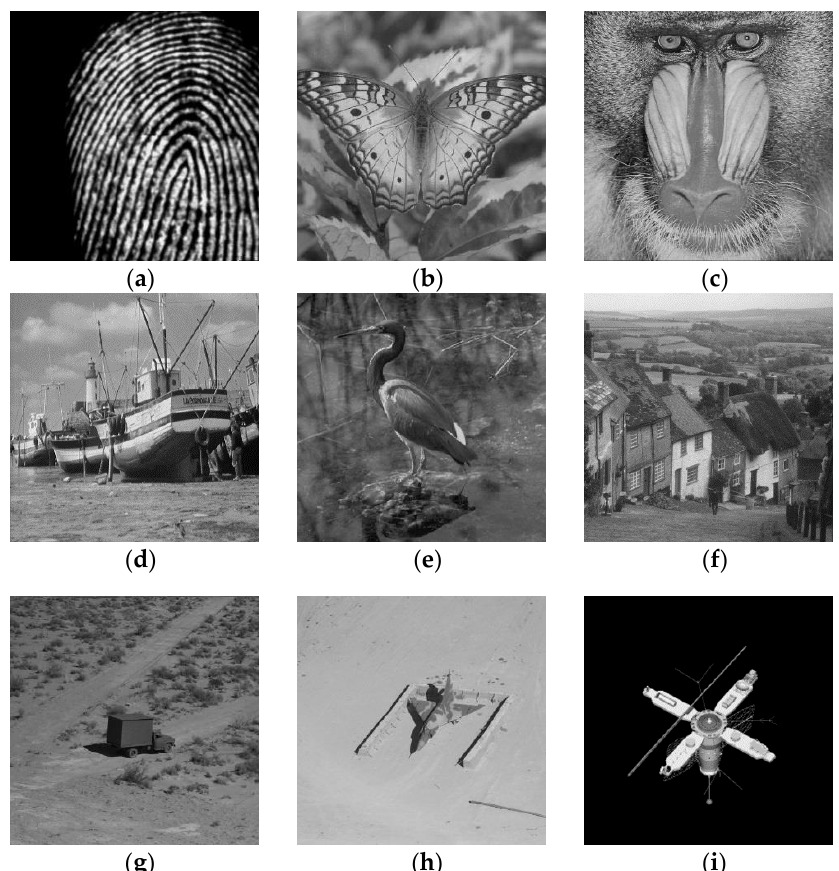
Figure 3. Images used in the simulation: ( a ) Fingerprint 256 × 256; ( b ) Butterfly 512 × 512; ( c ) Baboon 512